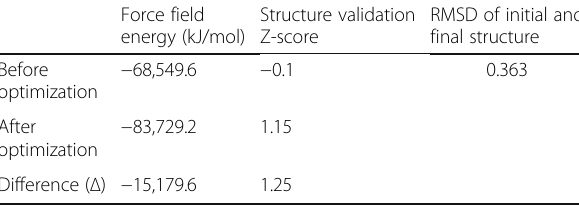
Table 9 Optimization parameter of phospholipase A2 (1KQU) Force field Structure validation energy (kJ/mol)